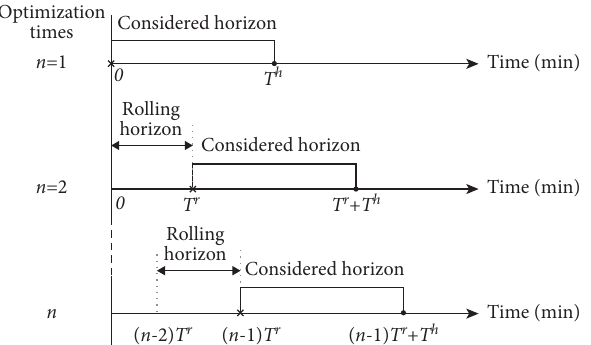
Figure 2: The rolling horizon framework.